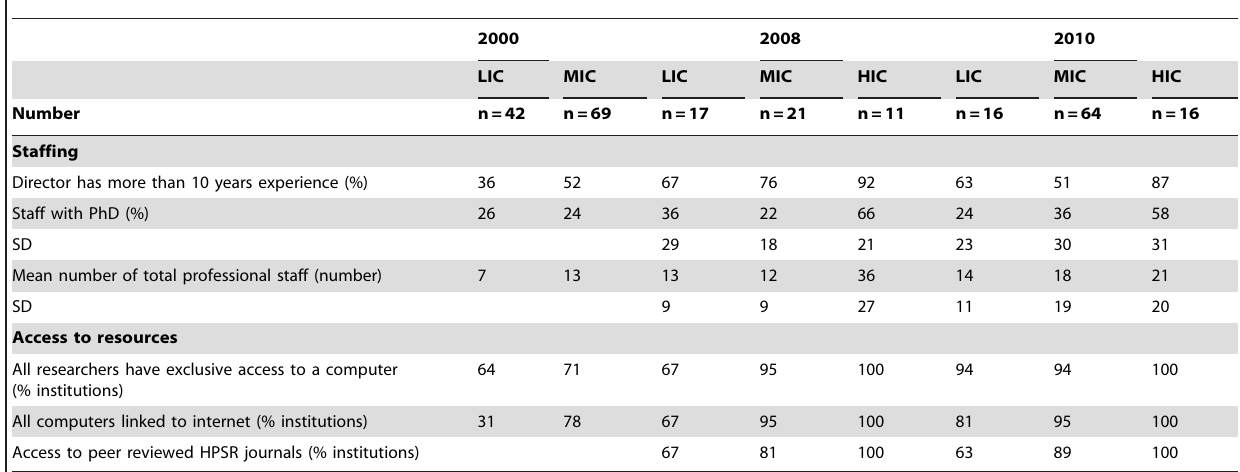
Table 5. Research Capacity in institutions undertaking